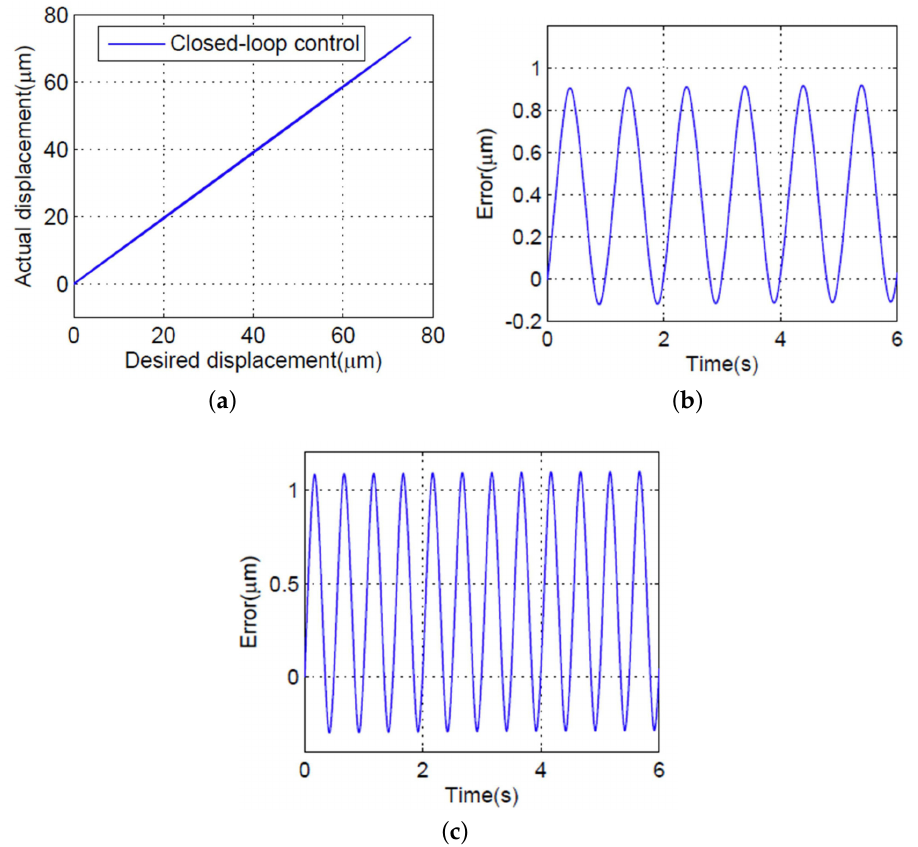
Figure 9. Experimental results with the feedforward hysteresis compensator and the proposed controller. ( a ) The relationship between the desired and the actual displacement of the PEA under a 1 Hz sinusoidal input. ( b ) Tracking error in the case of a 1 Hz input signal. ( c ) Tracking error in the case of a 2 Hz input